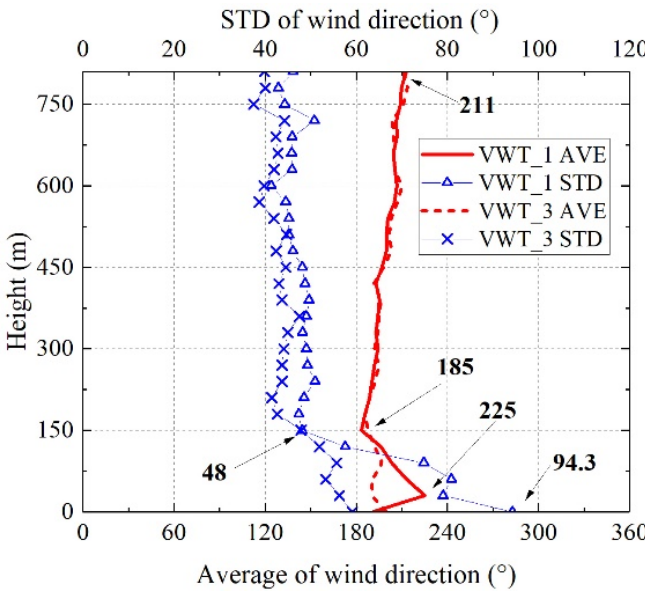
Figure 17. Average and STD of wind direction. Next, taking 150 m as the cutoff point, the data is divided into two parts, the first stage and the second stage. Statistical and fitting analysis was made for the AVE wind direction. Deflection of wind direction with height is treated as a linear piecewise function, as shown in Figure 18 and Equation